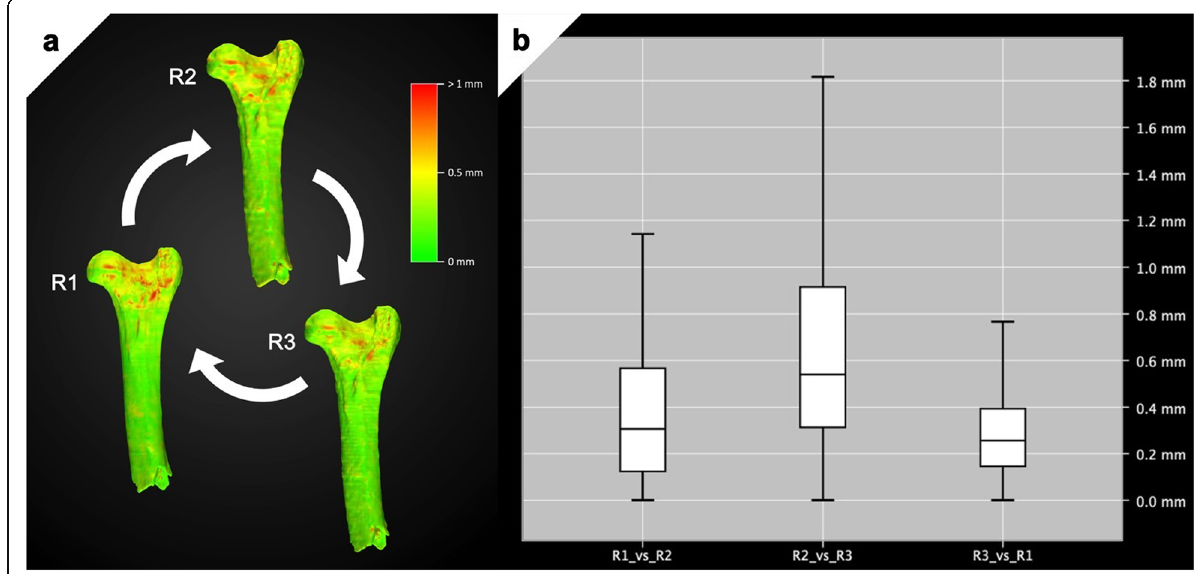
Fig. 4 Accuracy of resulting three-dimensional model. a Anterior view of resulting three-dimensional bone-models, after the virtual removal of speleothemic deposits, by three independent readers following a combined manual and HU threshold-based segmentation protocol. Projected colour-heat-maps illustrate differences between the respective model and the following model (clockwise). b The overall correlation between the three models is excellent, with over 68% of all points lying within a range of less than 1 mm, corresponding to less than three voxels on the computed tomography scan (voxel size = 0.33 × 0.33 × 0.67